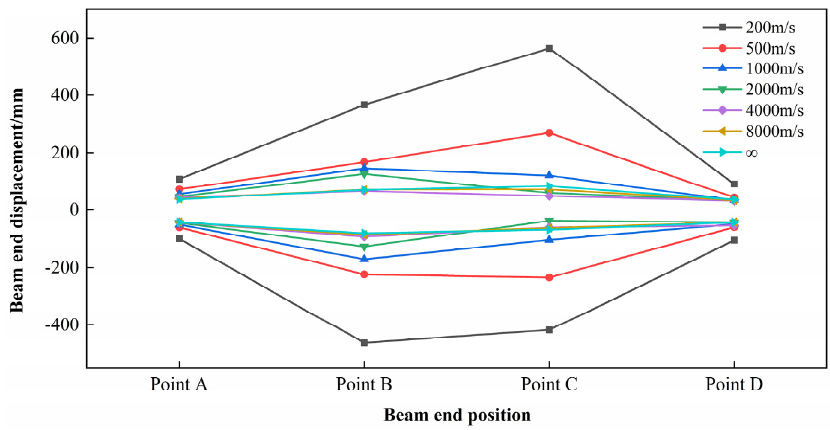
Figure 19. Longitudinal displacement of beam end at different apparent wave velocities.